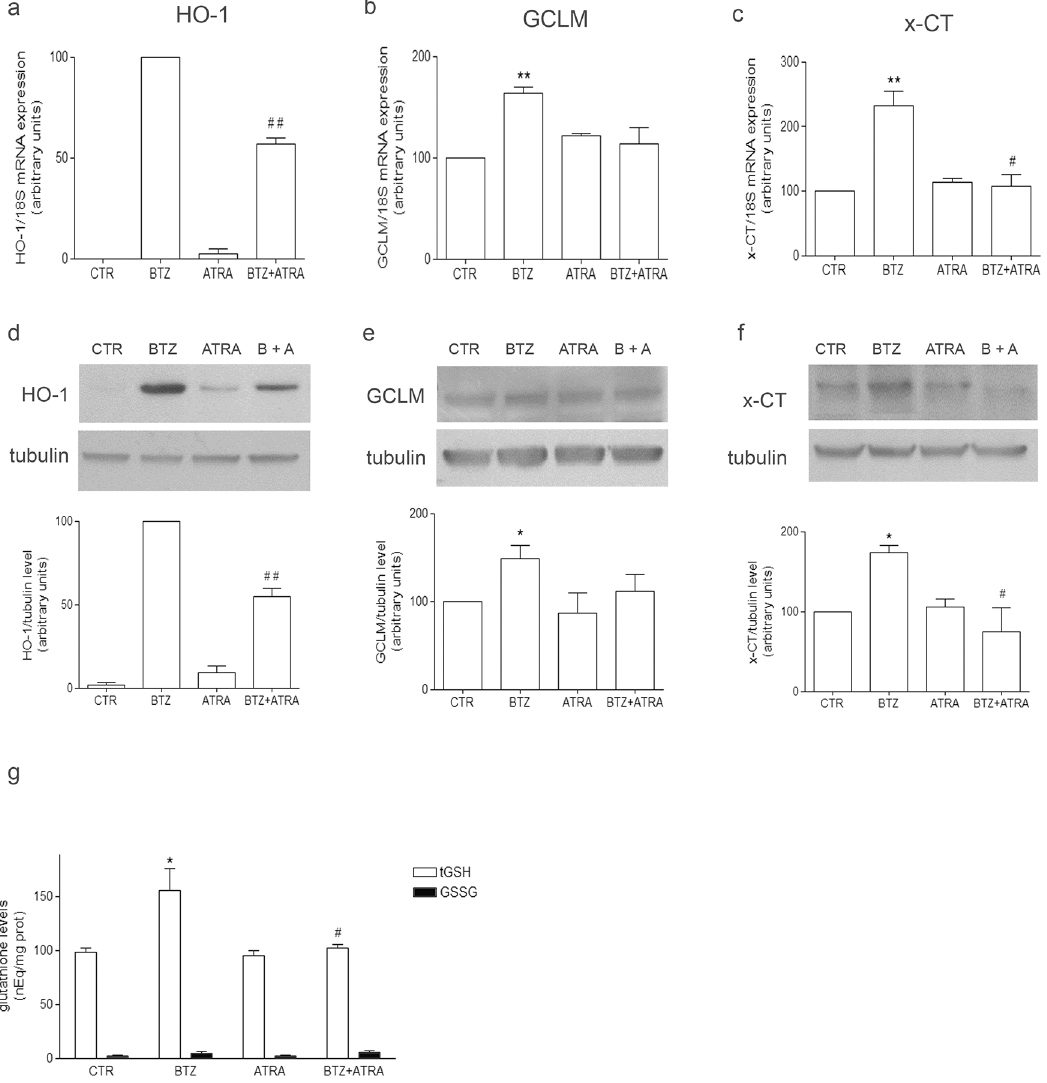
Fig 5. ATRA decreases mRNA expression of HO-1, GCLM and x-CT and lowers GSH level in BTZ-treated cells. mRNA and protein levels of HO-1 (a and d, respectively), GCLM (b and e, respectively) and x-CT (c and f, respectively) were detected by means of RT-PCR and Western Blotting in cells treated with 2.5 nM BTZ, 3 μ M ATRA and 3 μ M ATRA + 2.5 nM BTZ for 24 h, as detailed in Materials and Methods. The bar graphs show the mean values of three independent experiments (mean ± SE). The bands show one representative experiment. In (g) tGSH and GSSG content was measured by HPLC in cells treated with 2.5 nM BTZ and 3 μ M ATRA for 24 h, as indicated, and the graph shows the mean values of three independent experiments (mean ± SE); * p < 0.05 and ** p < 0.01 vs untreated cells; #p < 0.05 and ##p < 0.01 vs BTZ-treated